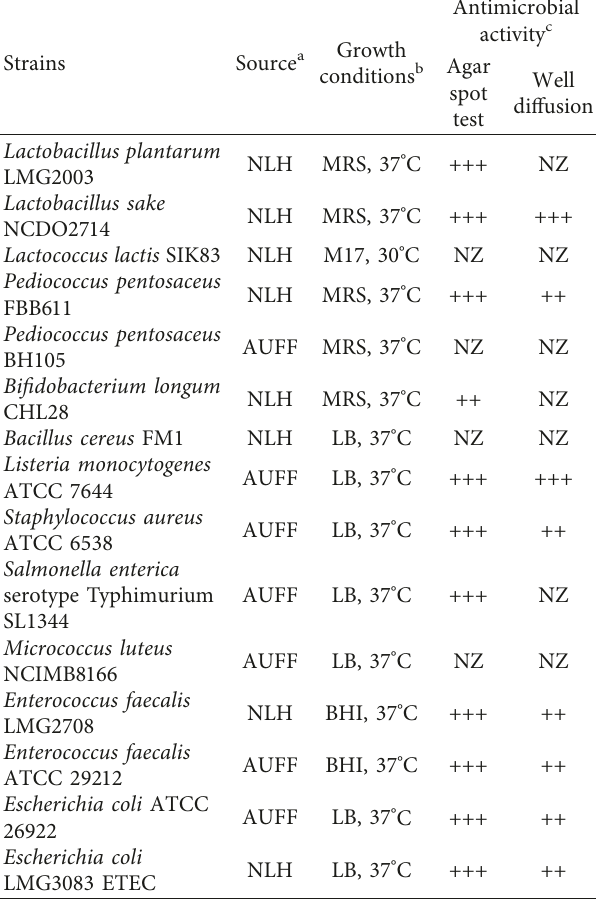
Table 1: Indicator strains and the antimicrobial activity spectrum of E. lactis